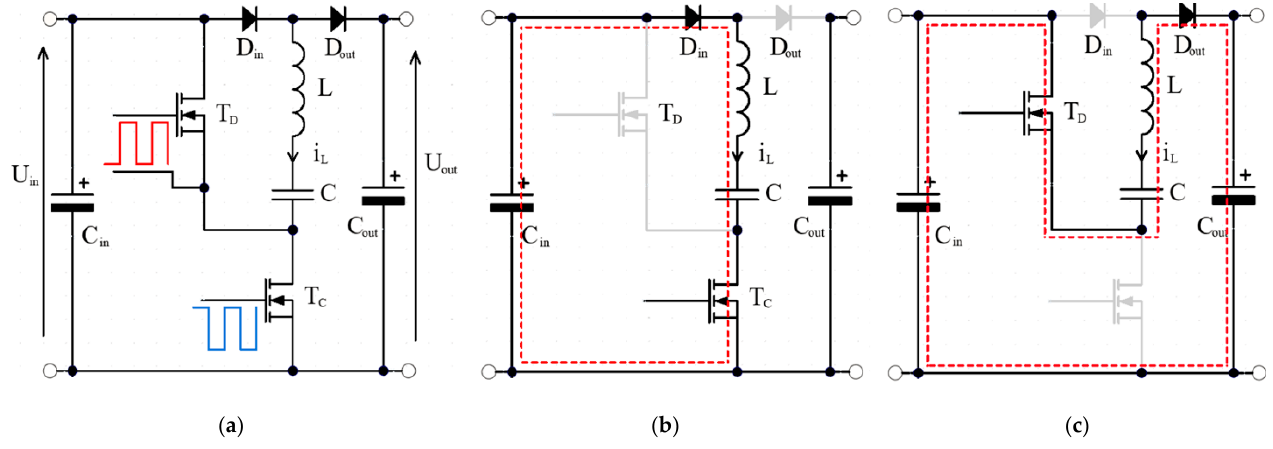
Figure 1. The power electronic unit: ( a ) unidirectional SC resonant voltage doubler. Stages of operation of the SCVD: ( b ) charging and ( c ) discharging of resonant capacitor.